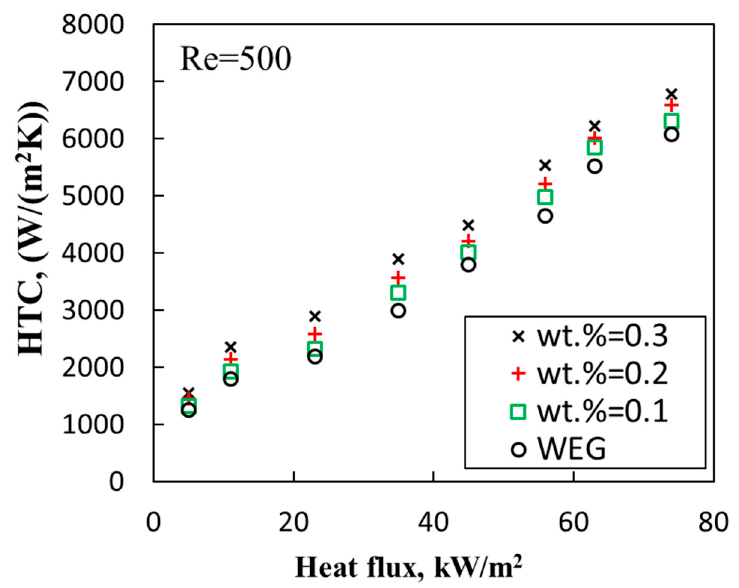
Figure 5. Variation of the HTC of the system with heat-flux at various mass fractions of NPGs.